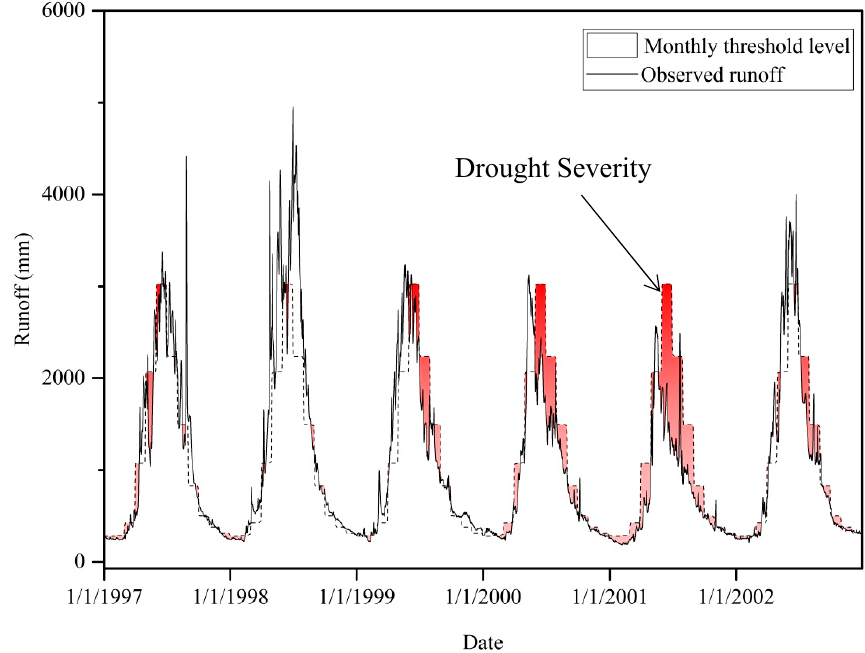
Figure 26. Example of drought analysis based on transient threshold levels for the Zone II.